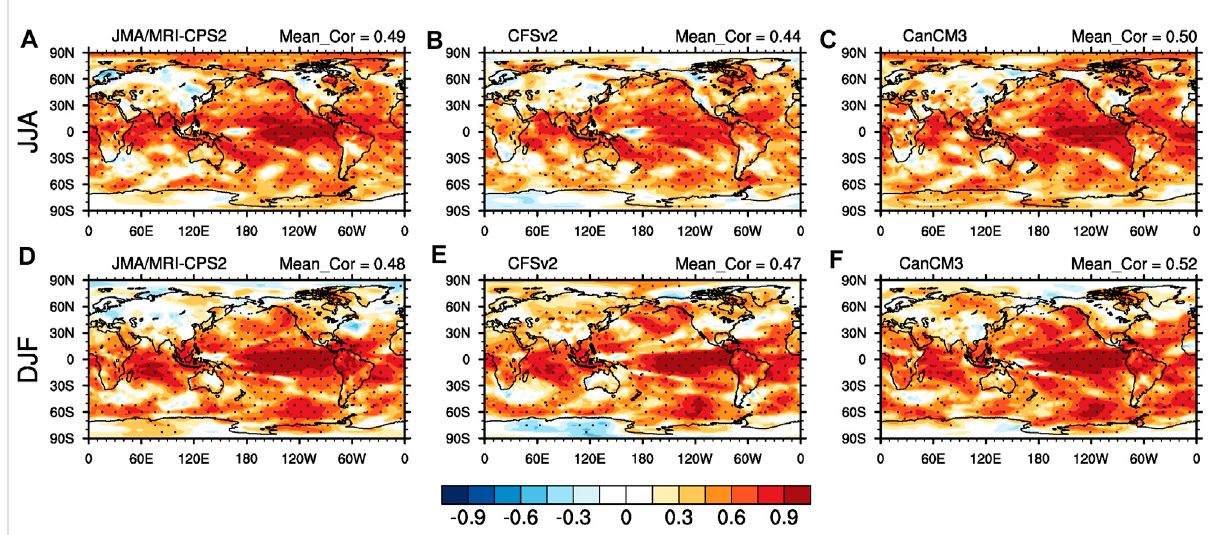
FIGURE 1 Spatial distributions of Temporal Correlation Coef fi cient (TCC) for JMA/MRI-CPS2 (A,D) , CFSv2 (B,E) and CanCM3 (C,F) of temperature in JJA (A – C) and DJF (D – F) season for the period 1982 – 2011. The global-averaged scores are also displayed in the upper right corner of the plot. The dotted areas indicate statistical signi fi cance at the 95% level using the Student ’ s t -test.